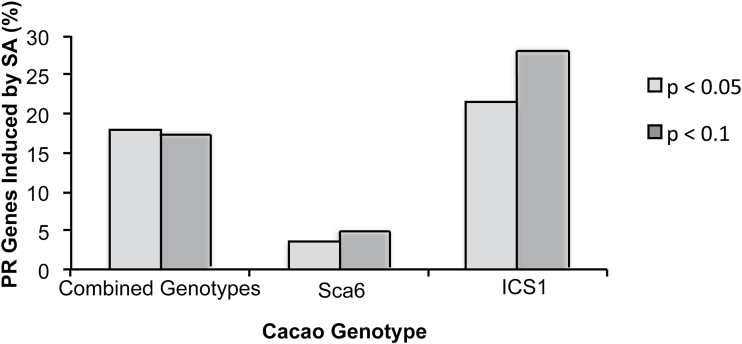
Number of PR genes induced by SA treatment for all leaf stages in Sca6 alone, in ICS1 alone, and across both genotypes. Y-axis shows percentage of PR genes included on the microarray that were induced by SA. Light grey bars represent genes induced with BH P<0.05, dark grey bars represent genes induced with BH P<0.10.